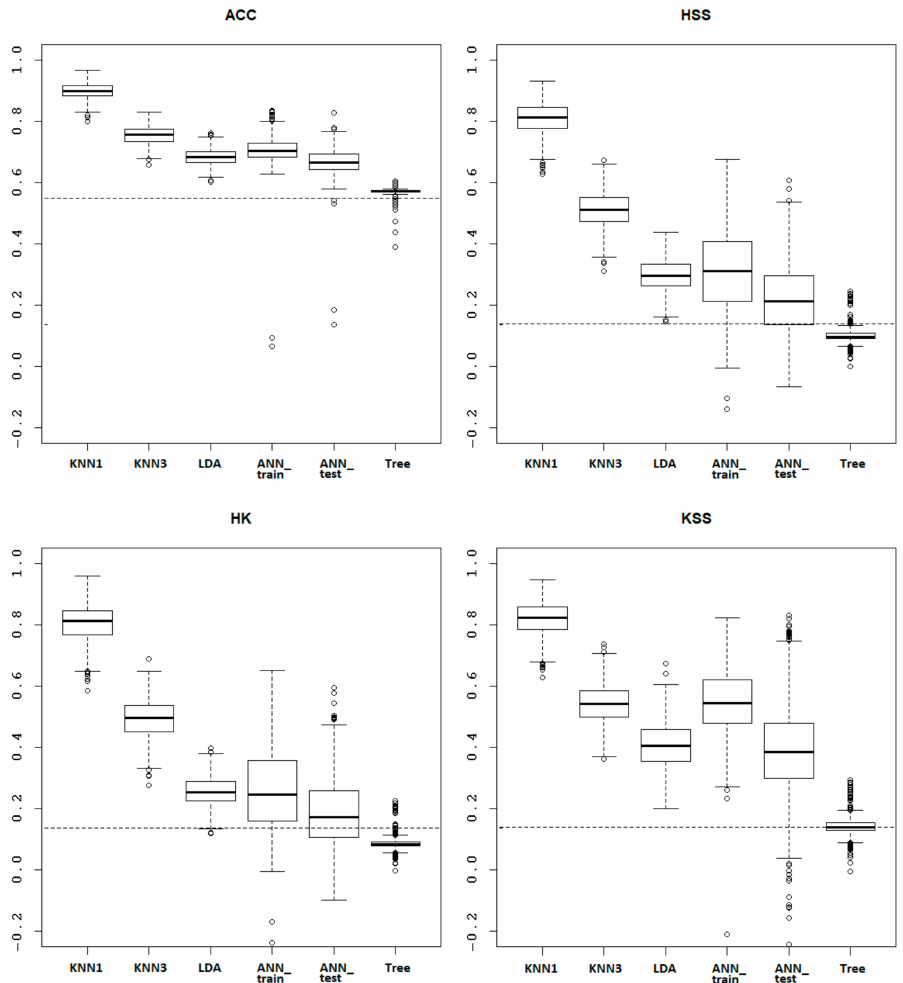
Figure 1. Performance scores (ACC, HSS, HK and KSS) for the DM methods KNN, K = 1 (KNN1), KNN, K = 3 (KNN3), LDA, ANN on training data set (ANN_train), ANN on test data set (ANN_test) and Classification tree (Tree). The dotted horizontal line represents the Persistence model. For further abbreviations, see Appendix